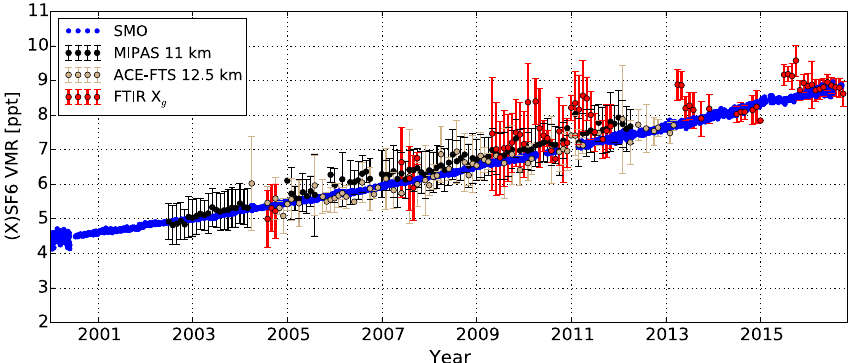
Figure 5. Time series of SMO in situ SF 6 daily median (blue), MIPAS SF 6 monthly mean (20–25 ◦ S) at 11km (black), ACE-FTS SF 6 monthly mean (0–40 ◦ S) at 12.5km and FTIR X SF monthly mean at St Denis and Maïdo (red). For MIPAS, ACE-FTS and ground-based 6 FTIR measurements, the error bar is the standard deviation within 1